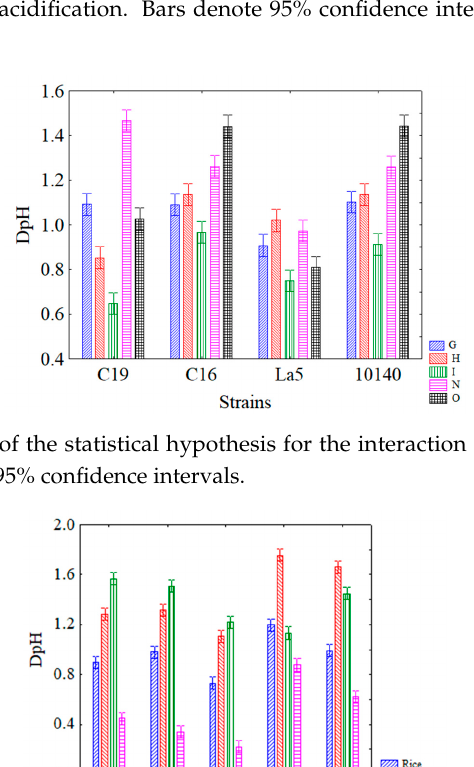
Figure 2. Decomposition of the statistical hypothesis for the individual terms of strains ( A ), beverages ( B ) and combinations ( C ) on acidification. Bars denote 95% confidence intervals. For the code of US treatments see Table 1.